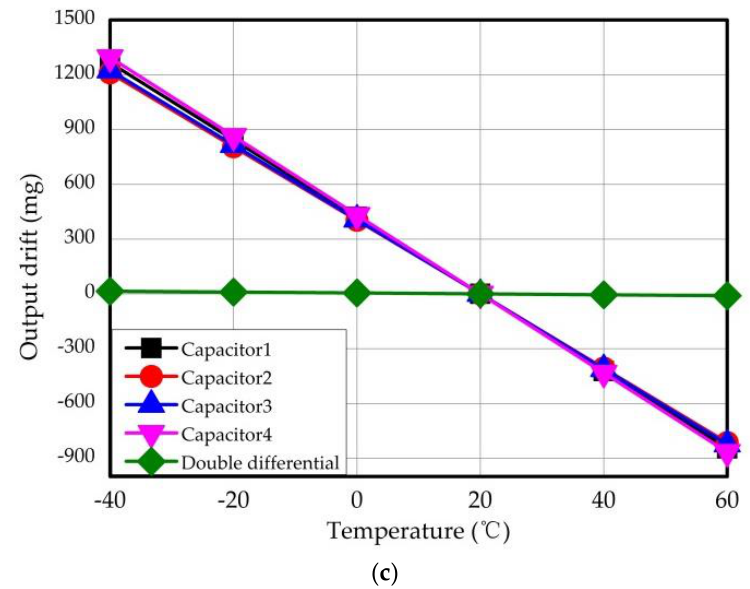
Figure 11. FEM simulation of the device at the temperature range from −40 ℃ to 60 ℃ : ( a ) The constrain condition of the simulation; ( b ) The deformation at high and low temperature; ( c ) The simulation results of temperature draft.